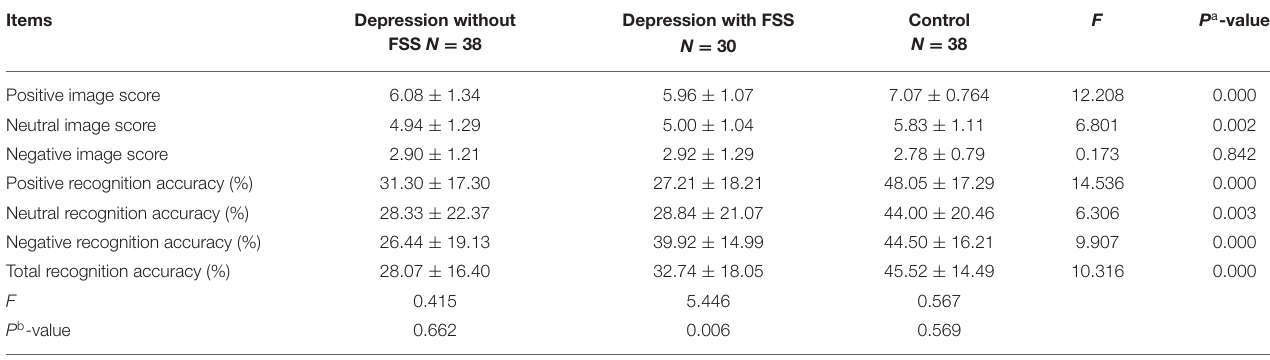
TABLE 3 | Comparative analysis of emotional memory by group ( X ± S ).